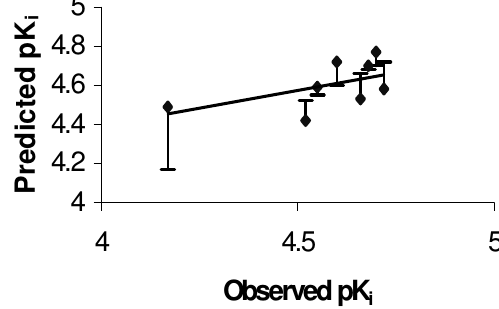
Figure 6. Plot between observed pK